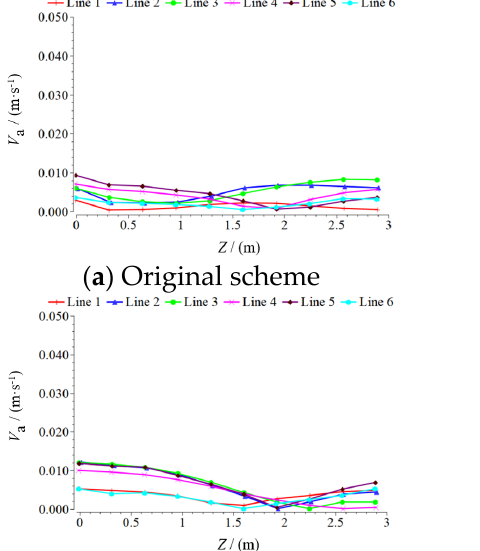
Figure 17. Diagram of axial velocity before the bell mouth in the sump 1#.